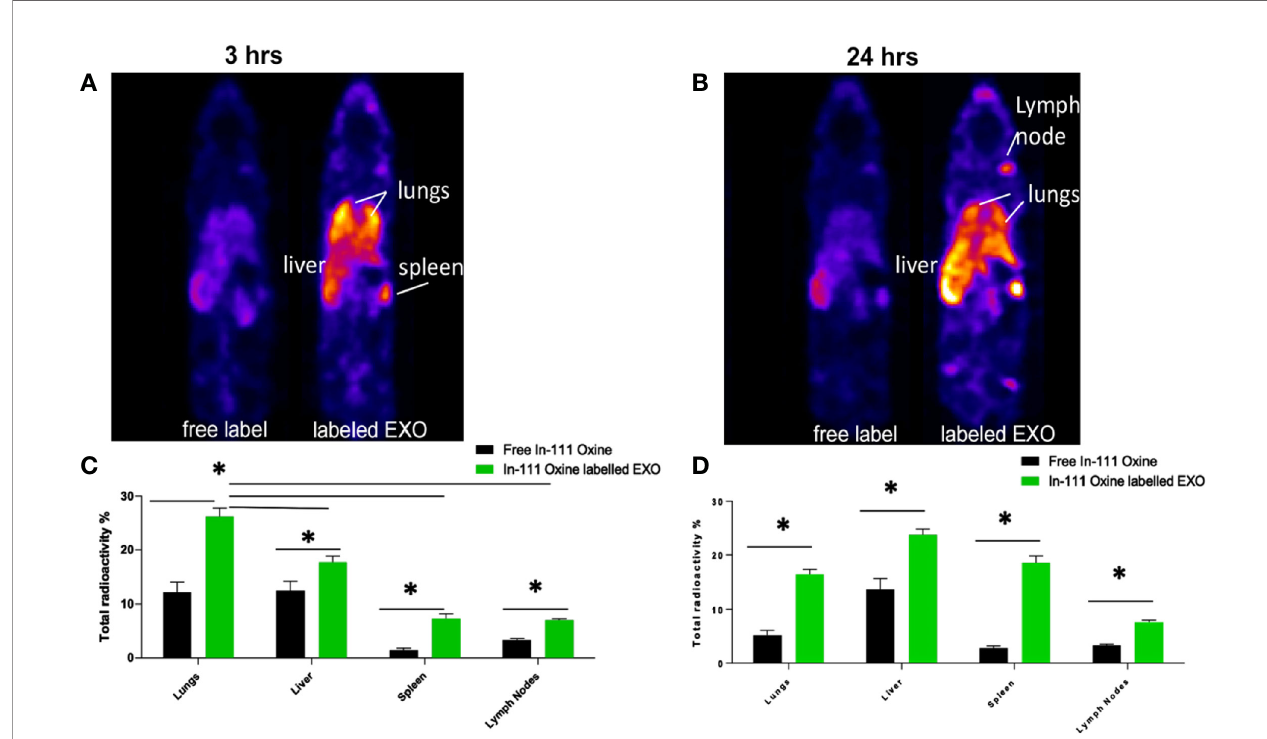
FIGURE 9 | Biodistribution of IV administrated EXO at 3 h and 24 h time points. SPECT CT live animal in vivo imaging of free In-111 (left) or In-111-labeled exosomes (right) in mice after (A) 3 h and (B) 24 h of IV administration. Radioactivity in lung, liver, spleen, and lymph nodes, relative to total, when free radiolabels or bound to DC EXO, expressed as % determined using SPECT CT images after (C) 3 h and (D) 24 h of EXO IV injection. N = 3; *P < 0.05 by two-way ANOVA, followed by Tukey ’ s multiple comparisons.